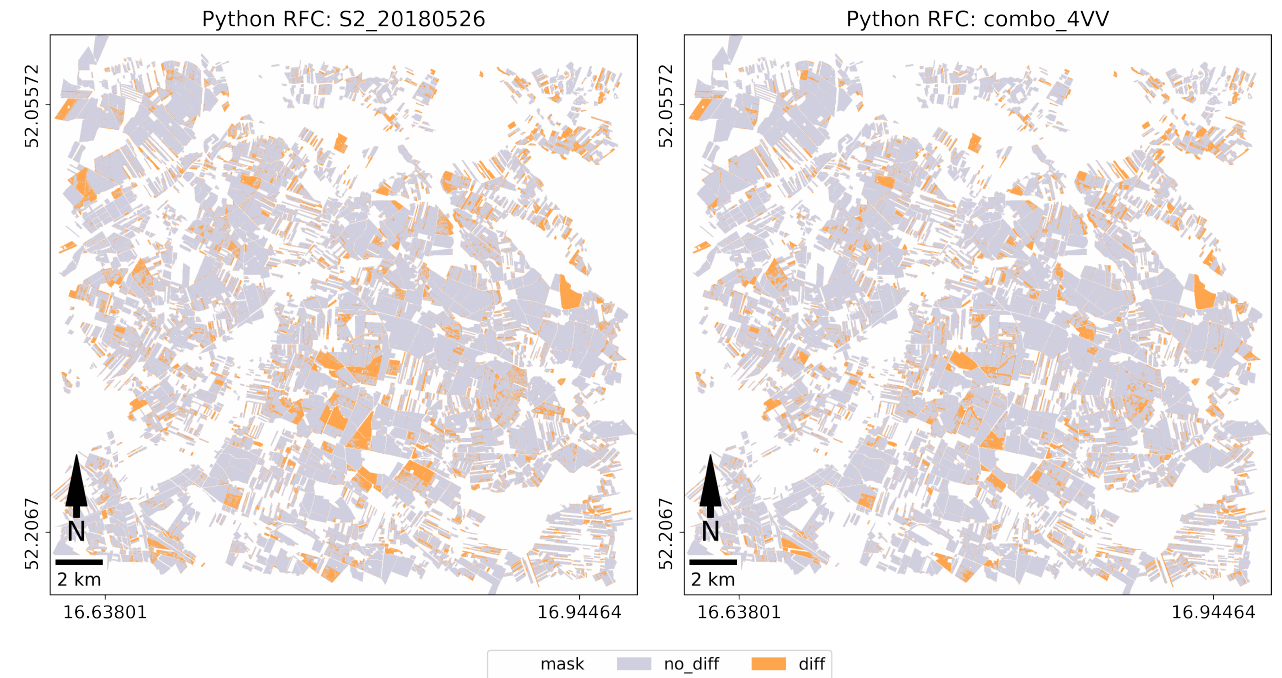
Figure 8. Map of discrepancies between farmers’ declarations and classification results (UTM34N coordinate). RF classification—the entire training set: 1,412,092 pixels. Confirmation in gray, difference between declared and classi- fied